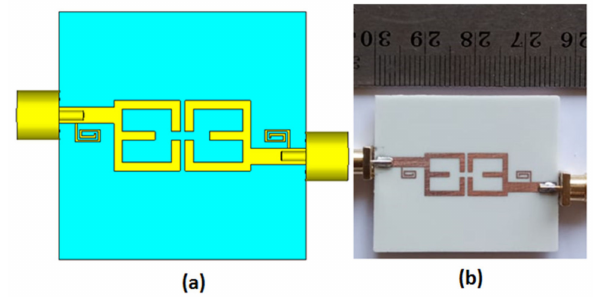
Figure 12. Stub loaded OLR with two spiral resonators BPF ( a ) 2-D layout ( b ) Fabricated photo.